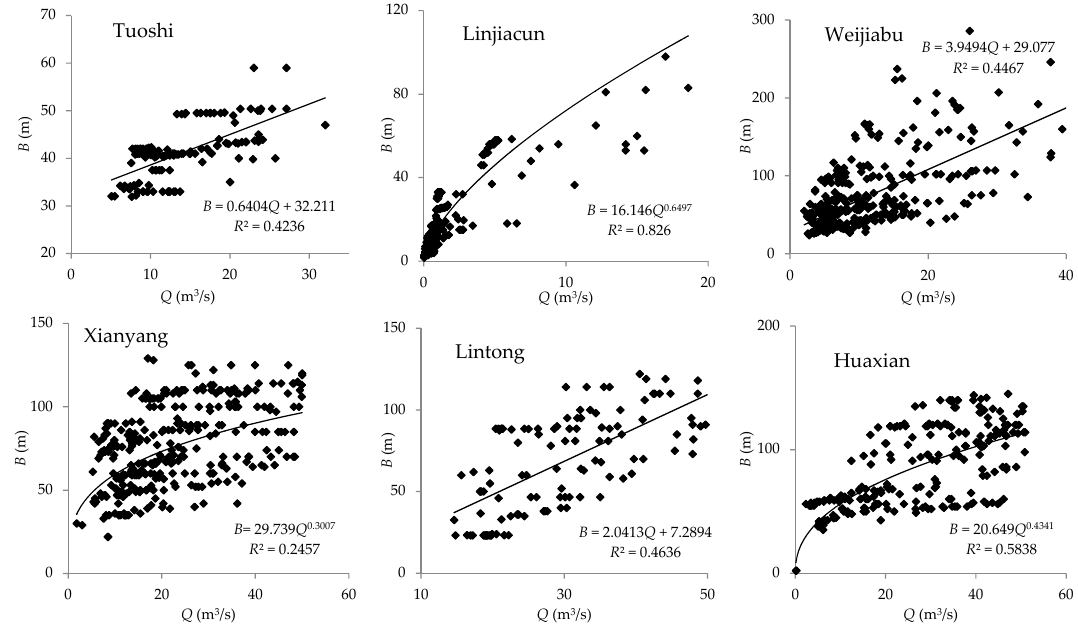
Figure 2. The fitting curve of low flow ( Q ) and water surface width ( B ) at 6 hydrological stations. Both Q and B were measured data provided by the Annual Hydrological Report of the People’s Republic of China (Yellow River Basin) .